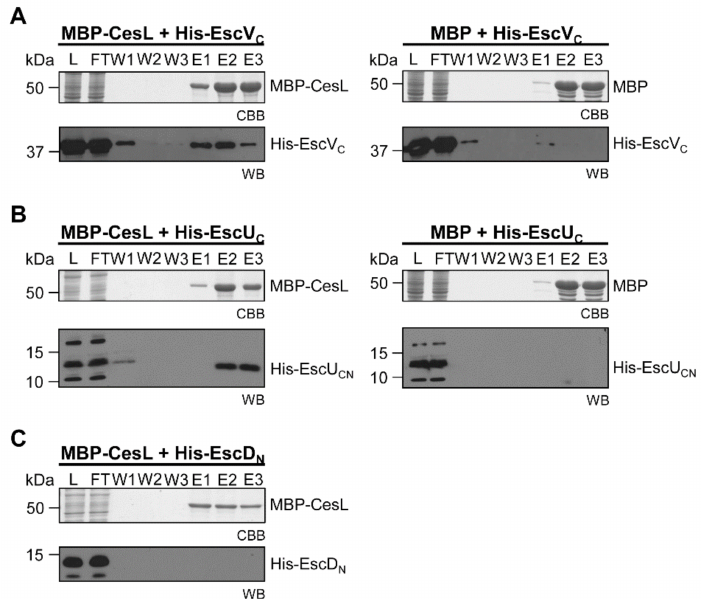
Figure 6. CesL interacts with the export gate components EscV and EscU. MBP-CesL (left panels) or MBP (right panels) was bound to a packed amylose resin and a cleared lysate (L) containing the His-tagged cytoplasmic domain of ( A ) EscV (EscV C ) or ( B ) EscU (EscU C ) and the mixture was loaded into the column. Samples from the flow-through (FT), washes (W) and elutions (E) were collected and analyzed by CBB-stained SDS-PAGE and immunoblotting (WB) using anti-EscV C or anti-EscU C polyclonal antibodies. ( C ) The His-tagged cytoplasmic domain of EscD (EscD N ) did not copurify with MBP-CesL and was used as a negative